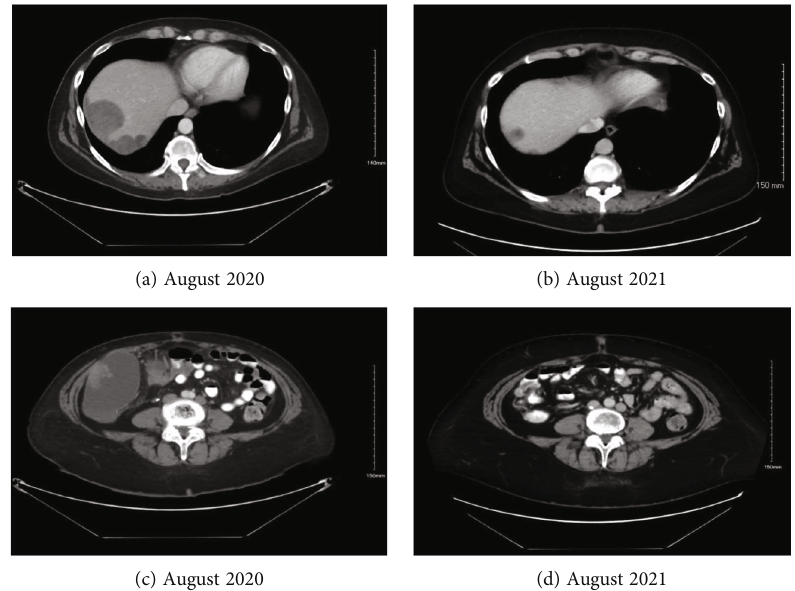
Figure 1: Interval decrease in disease burden over one year period of olaparib administration, including hepatic dome lesion from 58x42 mm (a) to 24x18 mm (b); lower right paracolic gutter lesion from 108x66 mm (c) to complete response